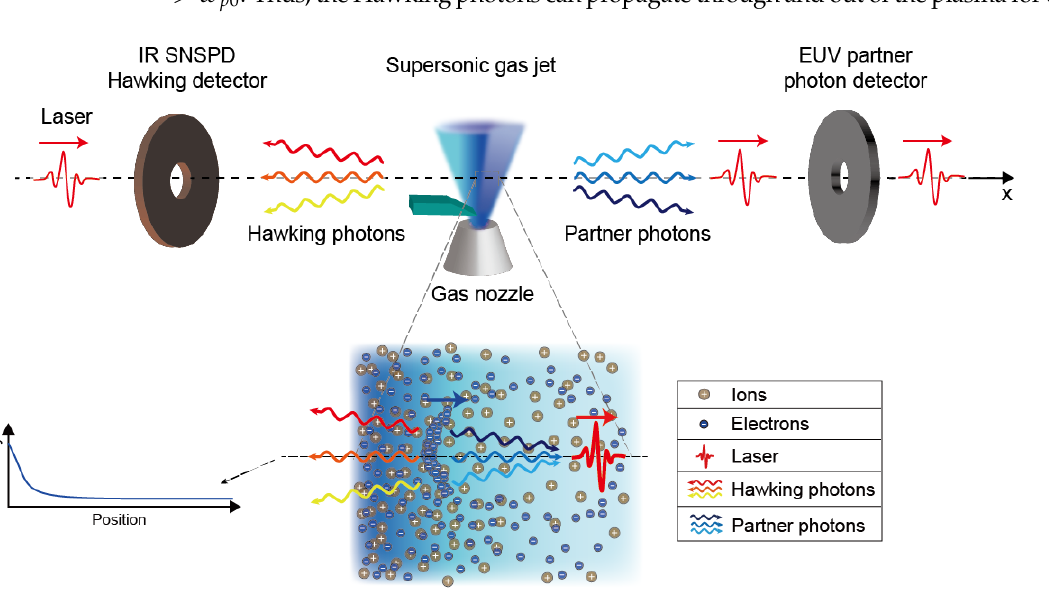
Figure 5. A conceptual design of the7 AnaBHEL experiment. The enlarged figure is a gaseous plasma target with a decreasing density profile where the penetrating optical laser pulse (red) would induce an accelerating flying plasma mirror (blue). Hawking photons would be emitted to the backside of the mirror, and would suffer from the Doppler redshift and be in the infrared range. The partner photons, on the other hand, would penetrate the semi-transparent plasma mirror and propagate in the same direction as that of the laser, which does not suffer from the Doppler redshift and would be in the EUV